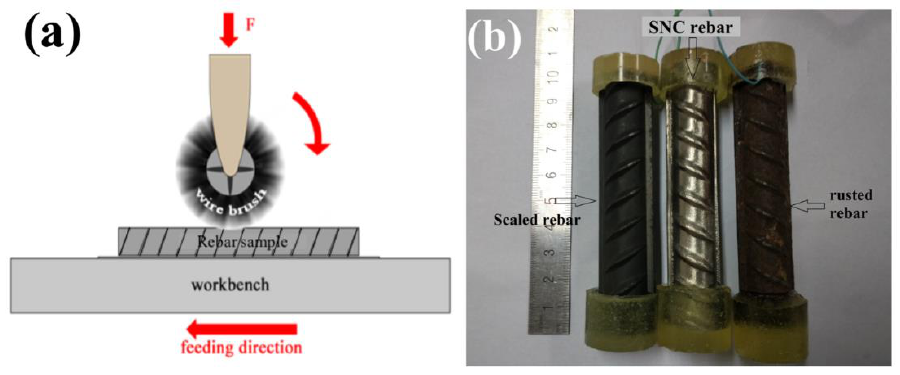
Table 1. Chemical compositions of Cr-alloyed rebar.